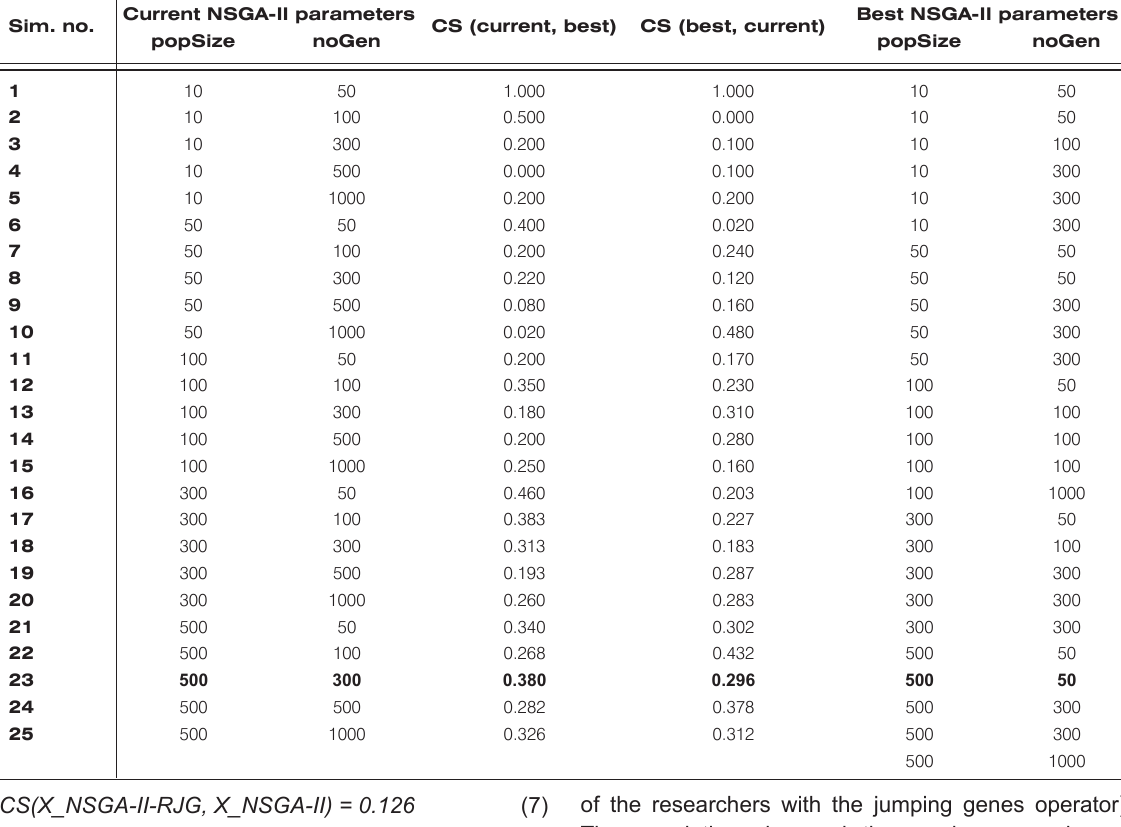
Table 6. The results of the simulations for different values of popSize and noGen with CrossProb = 0.9 and MutProb = 0.03 (set coverage metric) for NSGA-II. Sim.